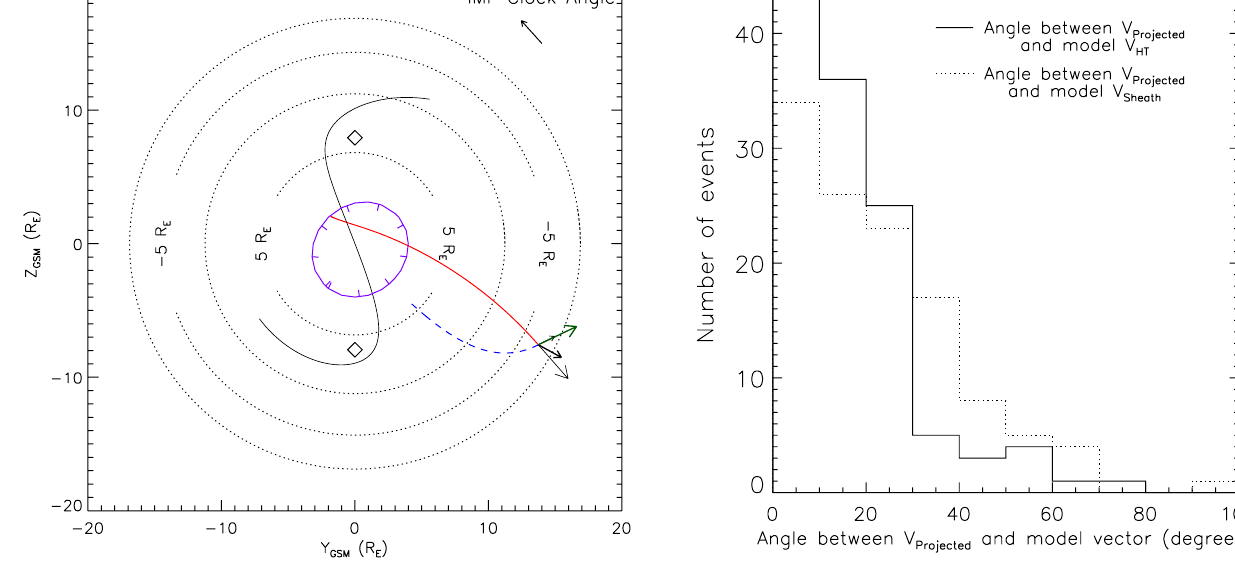
Fig. 8. An example model run for an FTE which is connected to the hemisphere opposite to that which would be inferred from the posi- tion relative to a subsolar component reconnection line (12 Novem- ber 2002, 14:42 UT). This figure takes the same format as Fig. 7. The direction of motion of the FTE is consistent with the model V HTS . The equatorward motion of the FTE is therefore a con- sequence of super-Alfv´enic magnetosheath flow at a high-latitude reconnection site (discussed by Fear et al., 2005b).